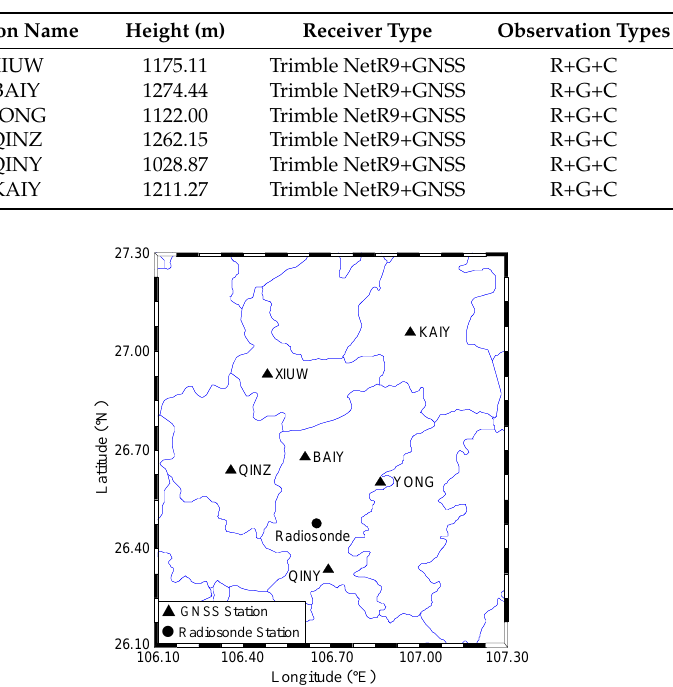
Table 1. Description of the selected ground-based multi-GNSS stations in Guiyang.